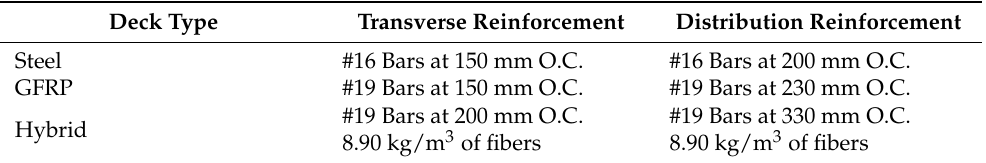
Table 1. Deck reinforcement